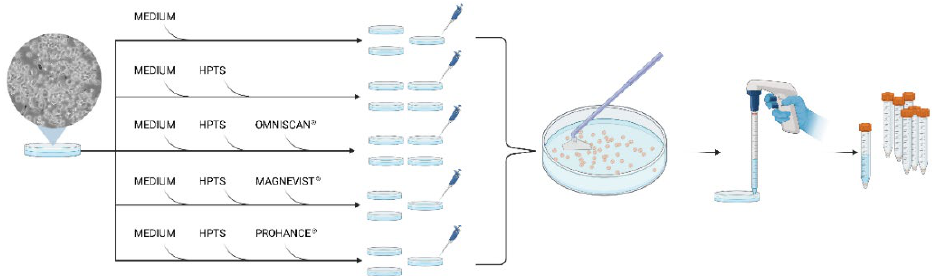
Figure 7. Graphical representation of experimental setup, highlighting the use of replicates for statistical analysis. The incubation conditions have been reported, followed by detachment of the cells by the use of a scraper and washes with fresh PBS. Samples finally transferred into falcon for the subsequent pre-lysis fluorescence acquisition.